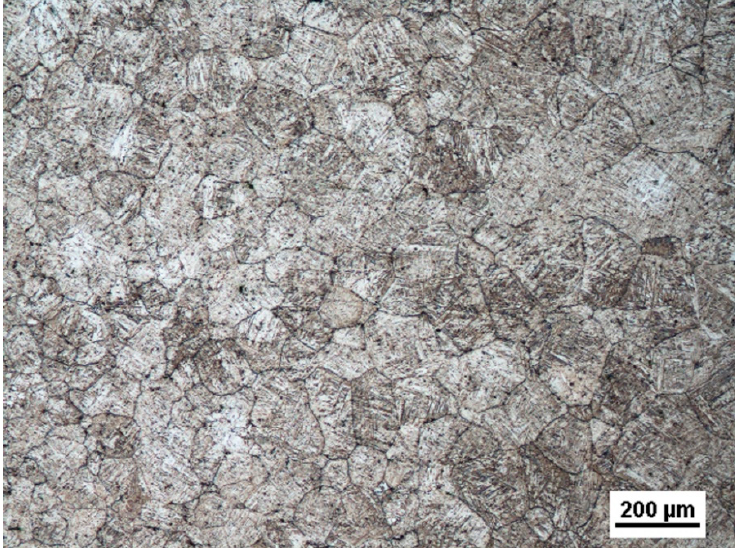
Figure 5. Microstructure of the Ti-6Al-4V titanium alloy after the SLM process (light microscopy) etched with Kroll’s reagent.